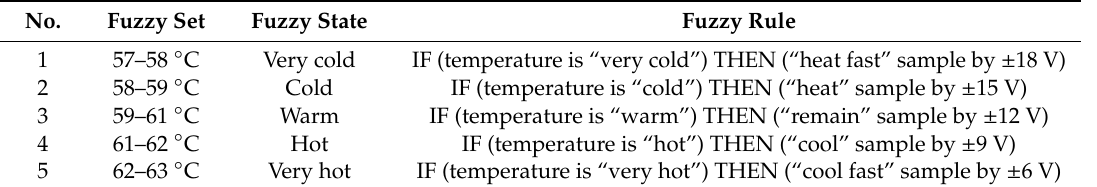
Figure 4. Proposed Fuzzy Logic Control System. Table 1. Fuzzy set, fuzzy state and fuzzy rule of the proposed control system.